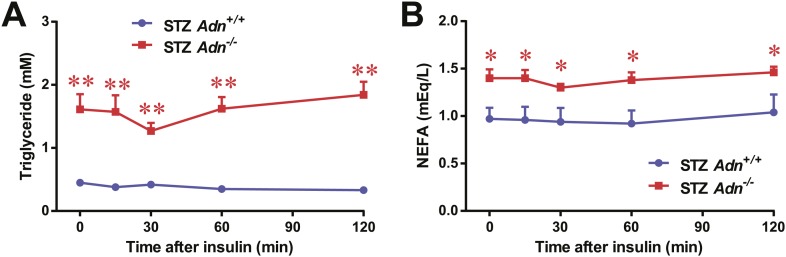
Serum triglycerides and NEFAs after low-dose insulin administration.Plasma triglycerides (A) and NEFAs (B) in mice after intraperitoneal injection of insulin (0.1 mU/g BDW). n = 7 mice per genotype. Data are presented as the mean ± SEM. *p < 0.05, **p < 0.01 for Adn+/+ vs Adn−/−. Related to Figure 2G.